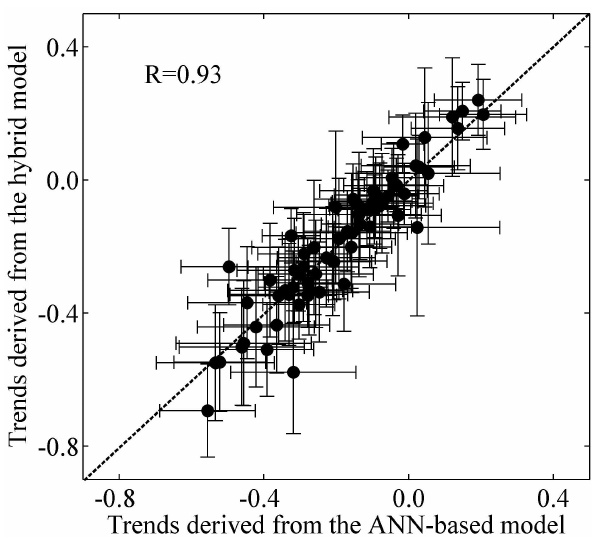
Fig. 4. Comparison of trend slopes in solar radiation estimates be- tween the ANN-based model and the hybrid model at all radiation stations during 1961 ∼ 2006. The filled black circles denote trend slopes, and the bars denote the 95% confidence intervals of the es- timated trend slopes. The unit of the trend is Wm − 2 yr − 1 .